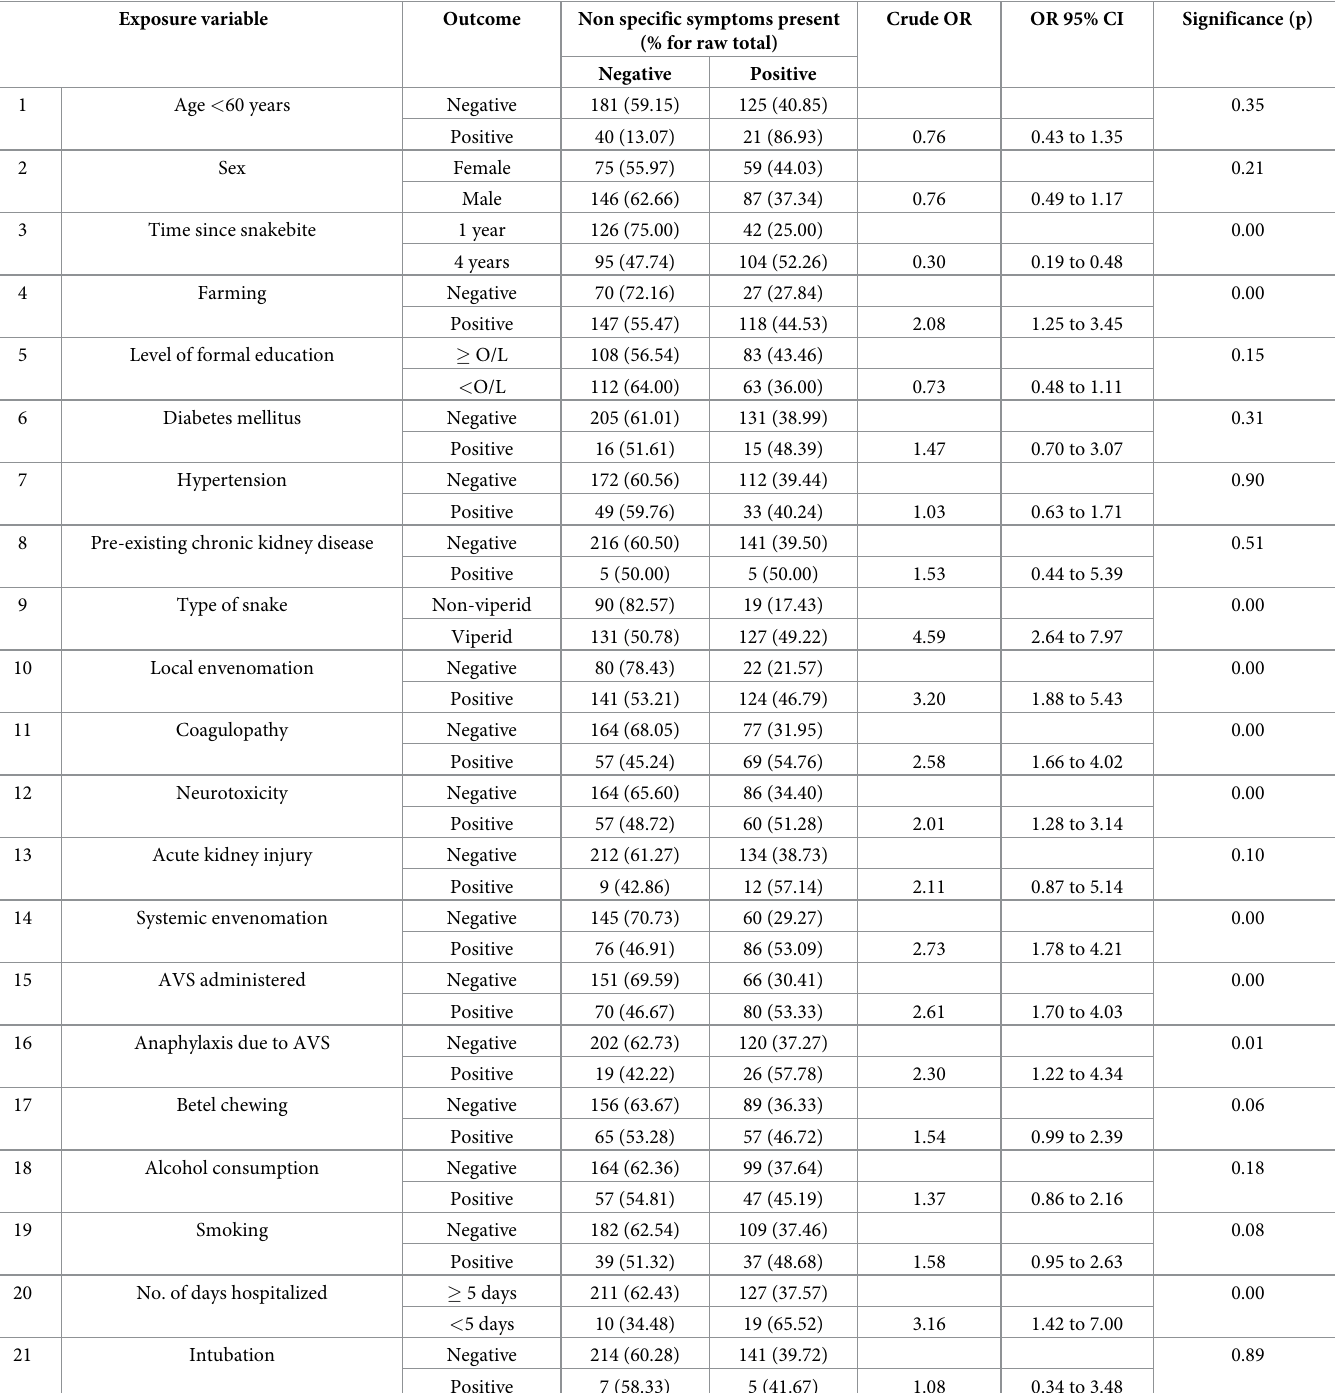
Table 5. Univariable logistic regression analysis: crude odds ratios for associations between symptoms that cannot be explained medically and all exposure variable. Exposure